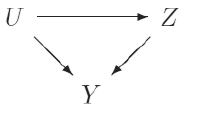
Figure 1 – 3-component completely recursive